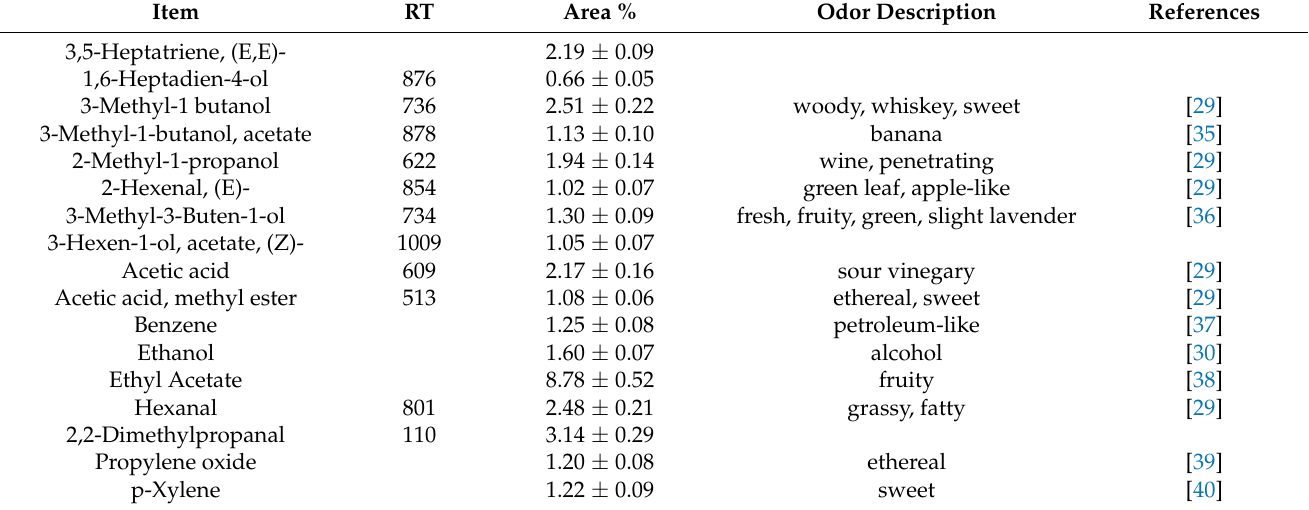
Table 6. Percentage composition of volatile compounds from raspberry seed oil obtained by